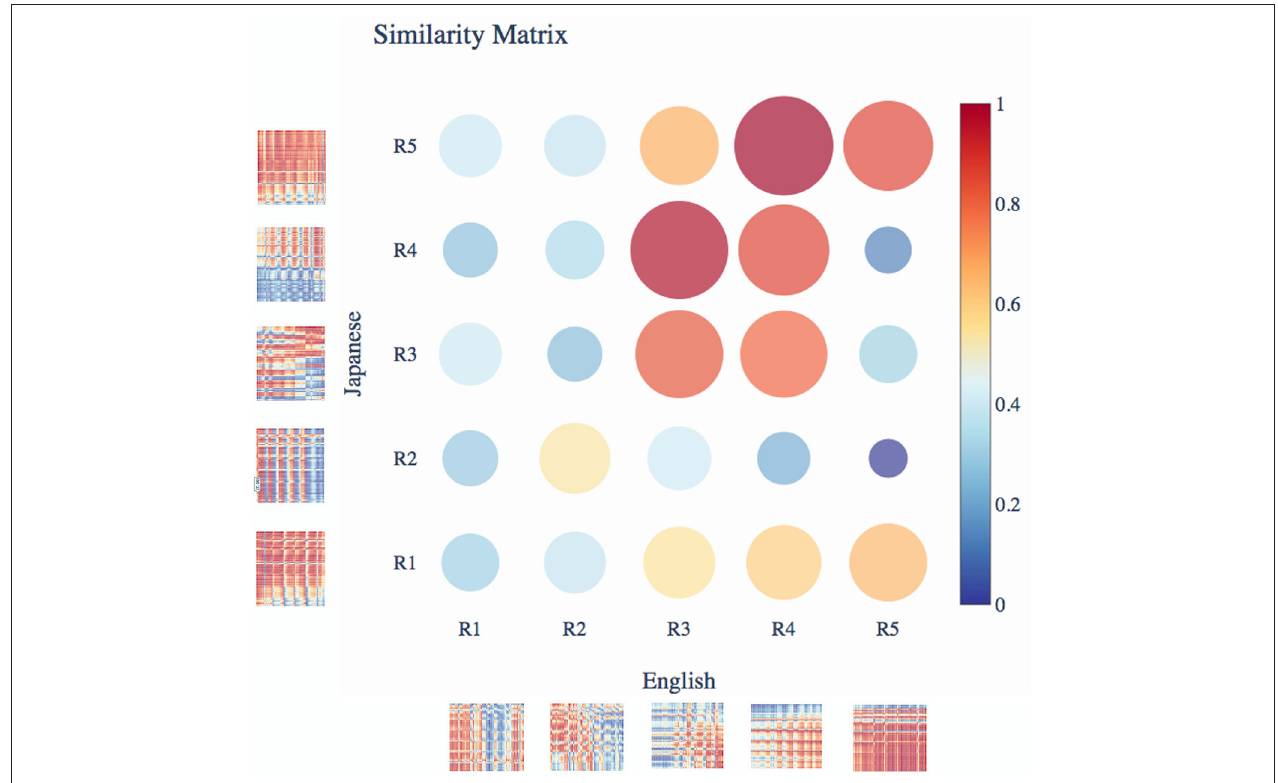
FIGURE 8 | Distance matrix between English and Japanese correlation matrices in different time-windows. The cross-channel correlation is computed between the congruent and incongruent end-word event-related potential (ERP) responses across all channels for English (S1) and Japanese (S3). The time regions in the figure are as follows R1: 50–200 ms, R2: 200–350 ms, R3: 350–500 ms, R4: 500–650 ms, and R5: 650–800 ms. The highest similarity was between English responses at R4 and Japanese responses at